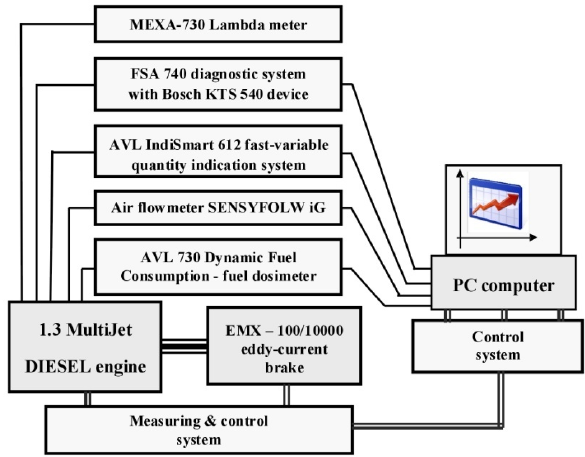
Figure 1: Block diagram of the test stand